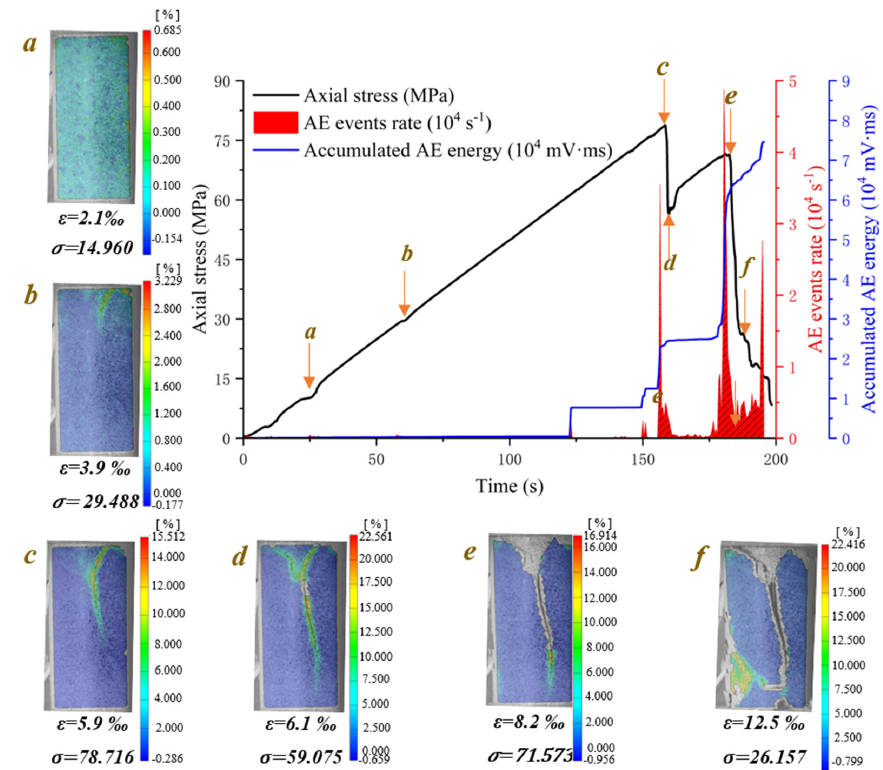
Figure 6. Crack evolution process of dry phyllite with 0° foliation angle (S-D-0°).